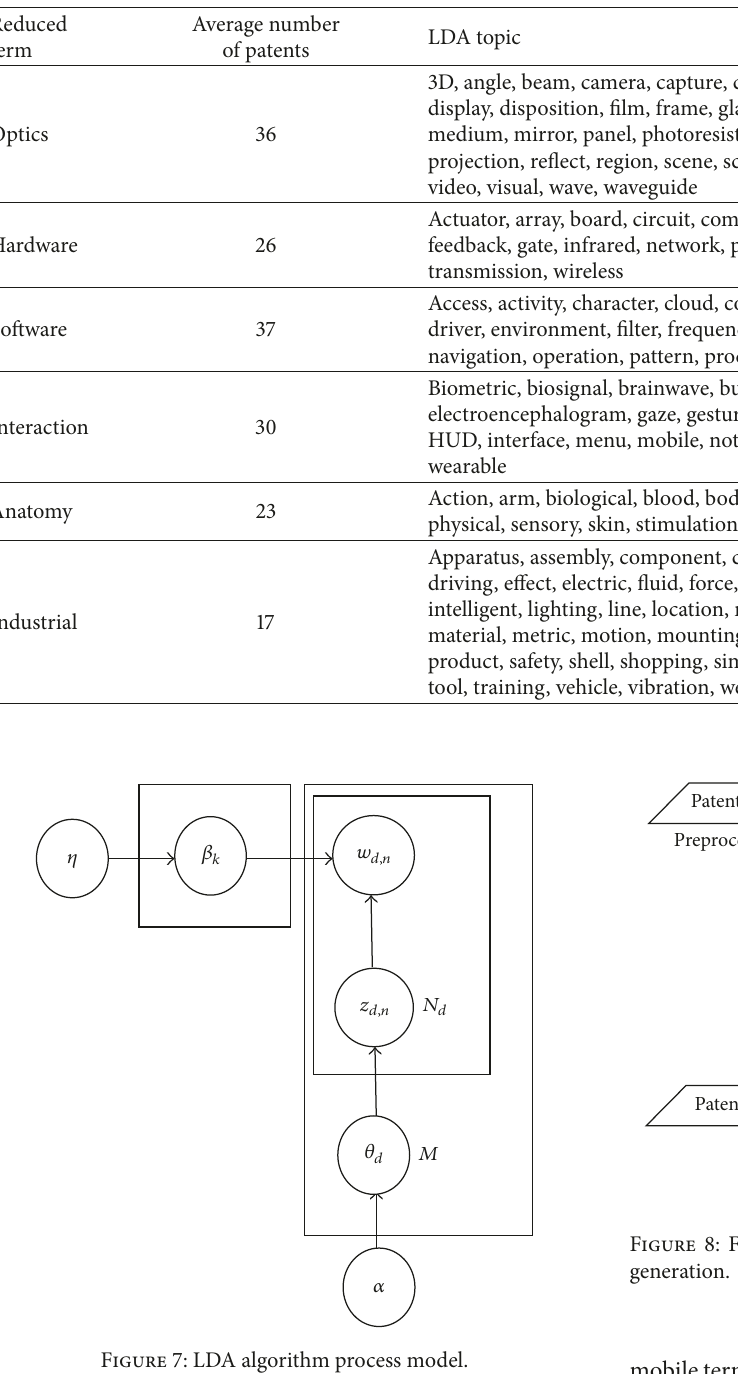
Table 8: IIT patent topic dictionary.